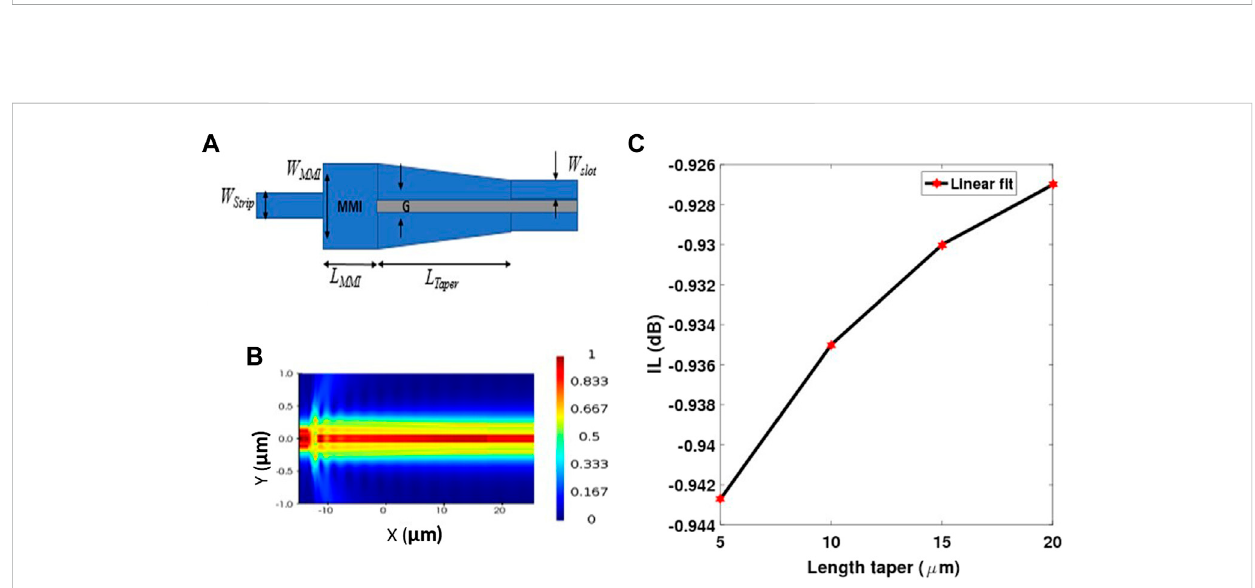
FIGURE 5 (A) The schematic of themode-converter showing theMMI section and the tapered section. (B) quasi-TE mode pro fi le of the mode-converter, and (C) the insertion loss of the mode-converter as a function of the length of its taper